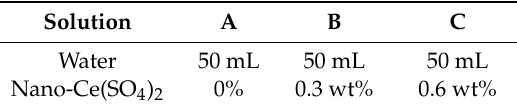
Table 3. CNT dispersion